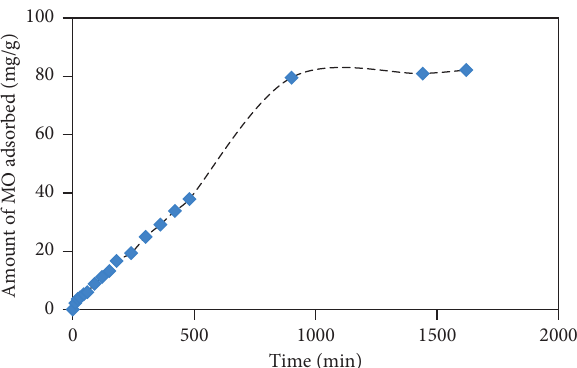
Figure 7: Effect of contact time on the adsorption of methyl orange onto cross-linked chitosan beads. Sample: 100mL methyl orange 20ppm; chitosan bead’s mass: 0.02g; stirring rate: 100 rpm.